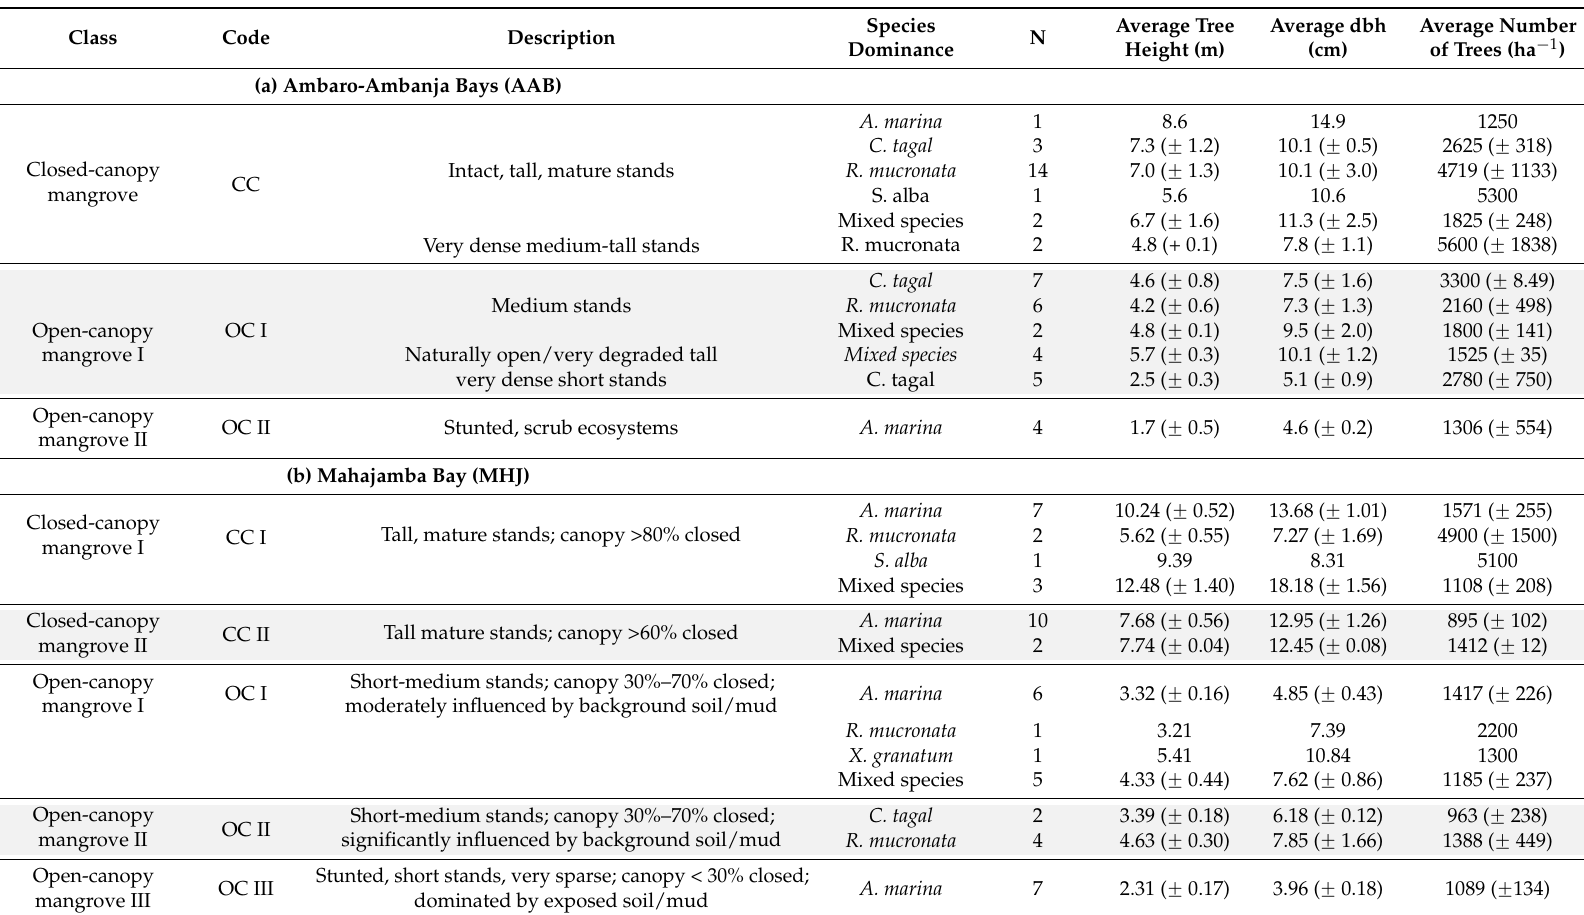
Table 5. Mangrove class, species dominance, average tree height (m) ( ˘ standard error (SE)), average dbh (cm) ( ˘ SE) and average trees per hectare (ha ´ 1 ) ( ˘ SE) for mapped mangrove categories. Adapted from Jones et al. [25] and Jones et al.